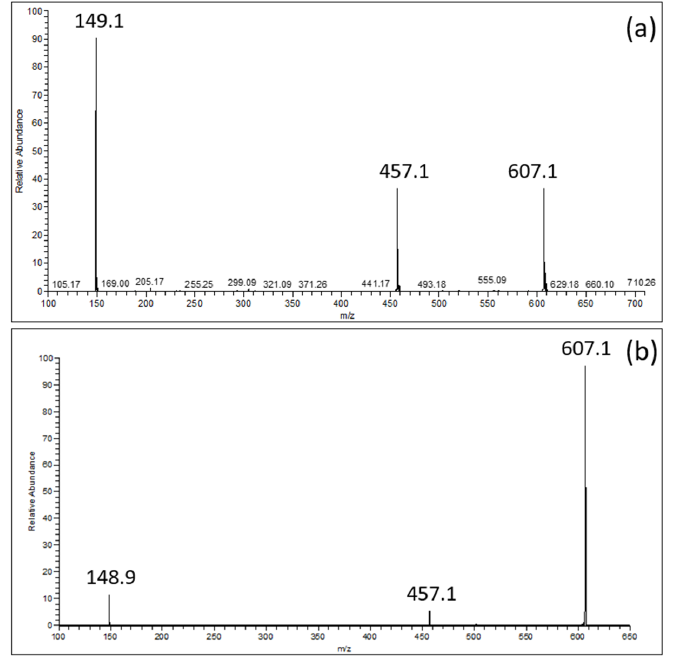
Figure 2. ( a ): ESI-MS spectrum of an EGCG–choline chloride solution; ( b ): ESI-MS 2 spectrum of the [(EGCG + Choline + HCOOH) − H] − product ion ( m / z = 607.1).